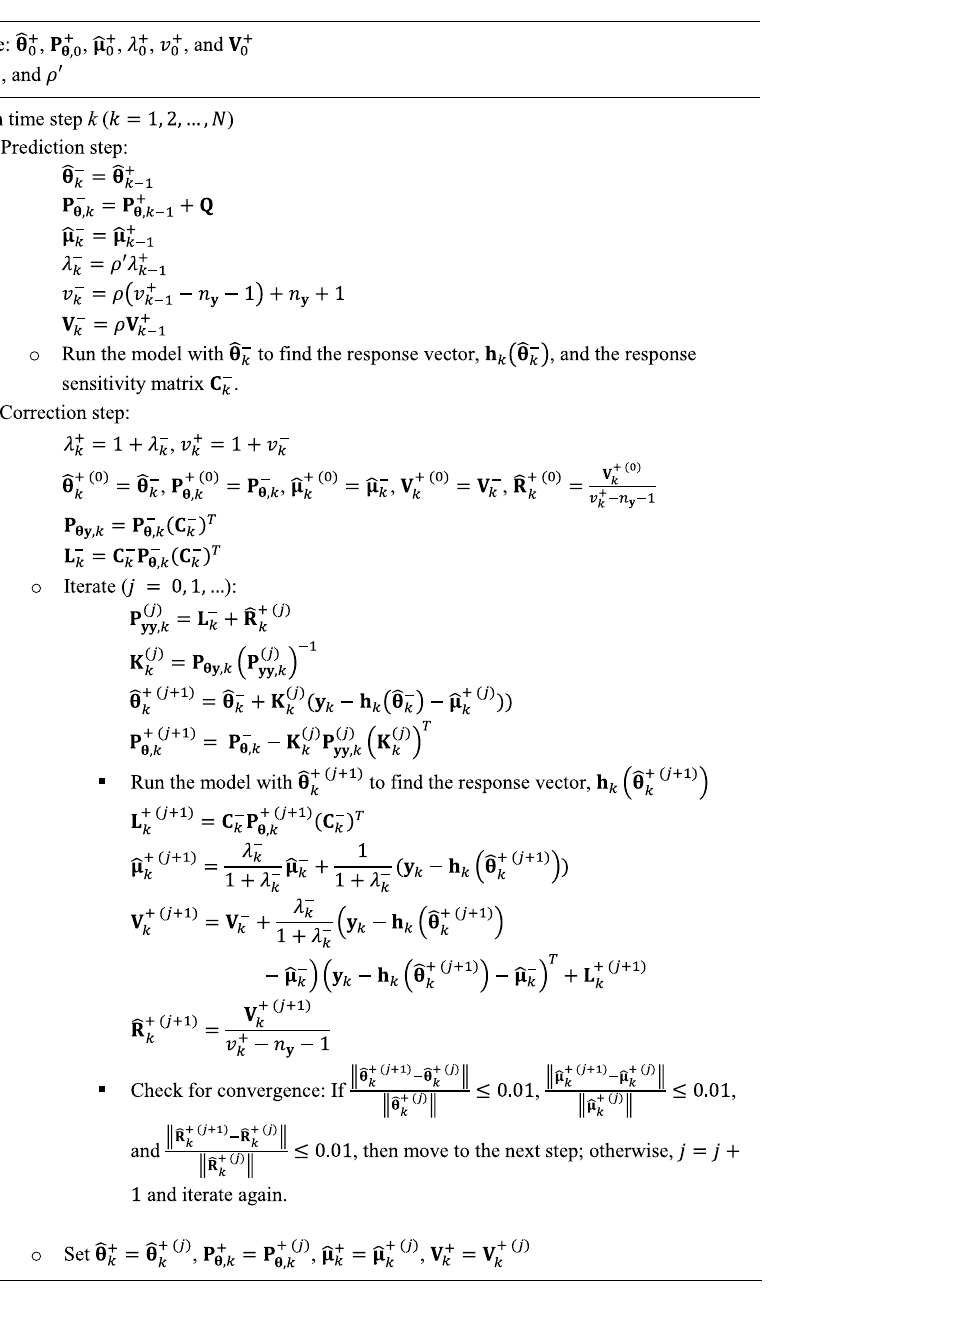
FIGURE 1 Algorithm for the recursive variational Bayesian (VB)